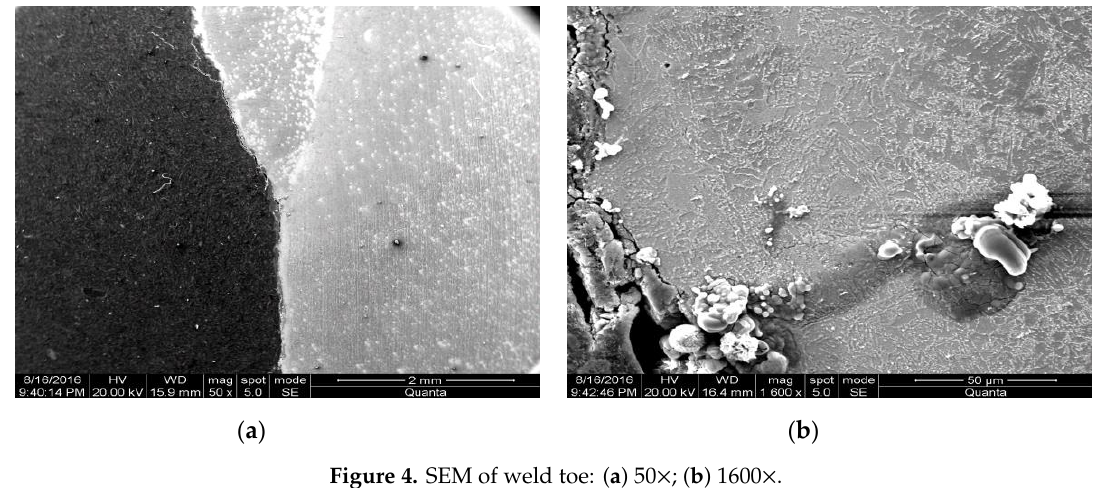
Figure 4. SEM of weld toe: ( a ) 50 × ; ( b ) 1600 × .